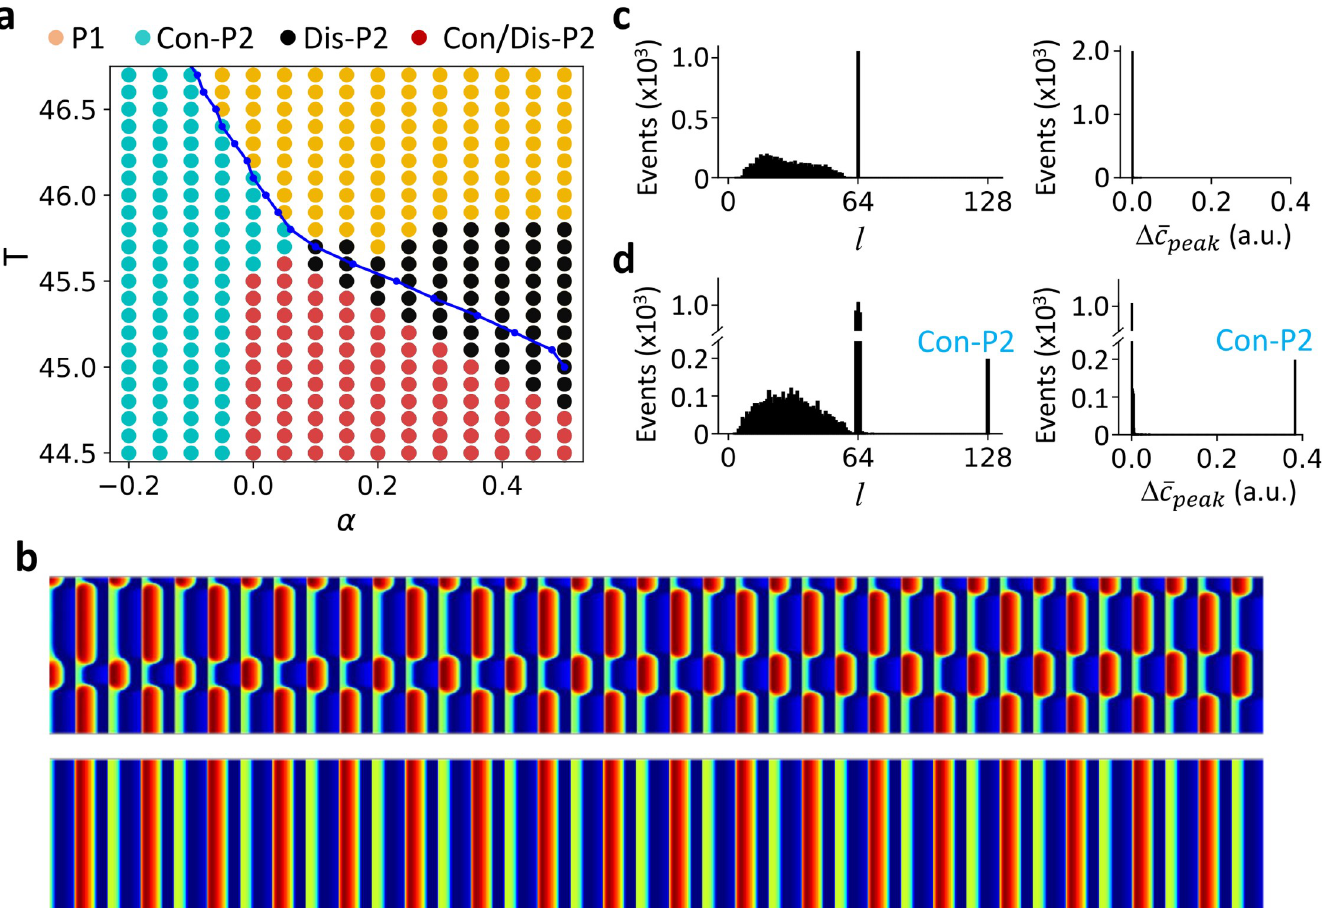
Fig 3. Excitation patterns and dynamics in a 1D array of coupled FHN units with DGF. a . Phase diagram of excitation dynamics. The blue line is the bifurcation boundary from P1 to P2 in an uncoupled unit with DGF. Color dots mark the different behaviors in the 1D array: yellow—uniform P1; black—Dis-P2; cyan—Con-P2; and red—Con/Dis-P2. b . A Dis-P2 pattern (upper) and a Con = P2 pattern (lower) for α = 0.2 and T = 45 obtained with two different initial conditions. c . Left, histogram of domain size l from 2000 trials. α = 0.4 and T = 45.5. The random initial conditions were set the same way as described in Fig 2 legend with δ = 3. For each trial, 2000 beats were applied for the system to reach a steady state. Right, corresponding histogram of global P2 amplitude D � c panel c but for α = 0.2, T = 45, and δ =